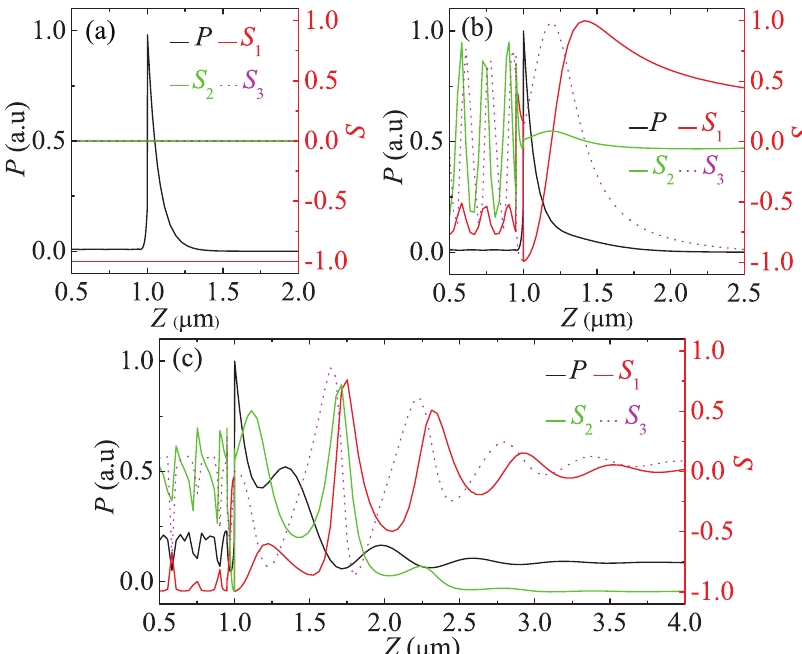
Figure 4. Lateral distribution of Poynting vectors ( P ) and Stocks parameters ( S 1 , S 2 , and S 3 ) for the SPPs and the HSPPs excited at the Kretschmann configuration. ( a ) ϕ = 0 , TM SPPs; ( b ) ϕ = 30 ◦ , the HSPPs excited at the reflectance dip in Figure 2a; ( c ) ϕ = 50 ◦ , the HSPPs excited at the left reflectance dip in Figure